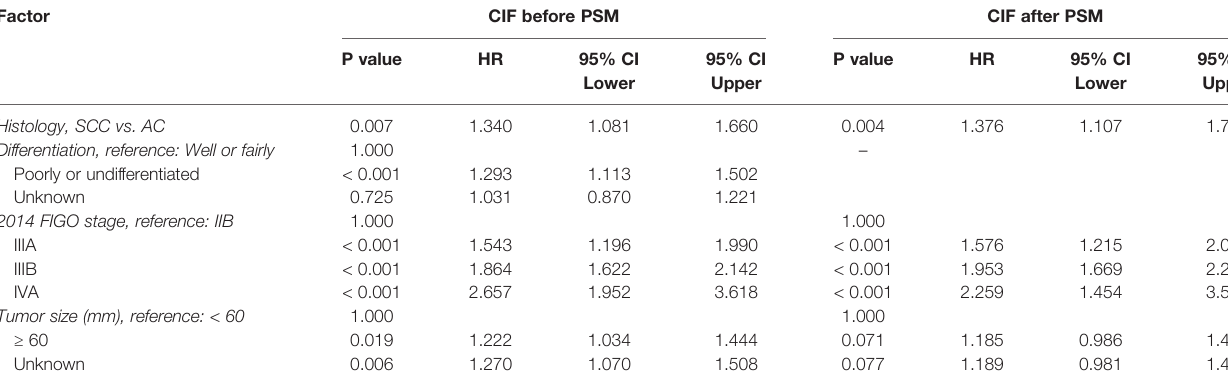
TABLE 3 | Multivariate analysis of OS in patients with CC using the Fine-Gray regression model before and after PSM. Factor CIF before PSM CIF after PSM P value